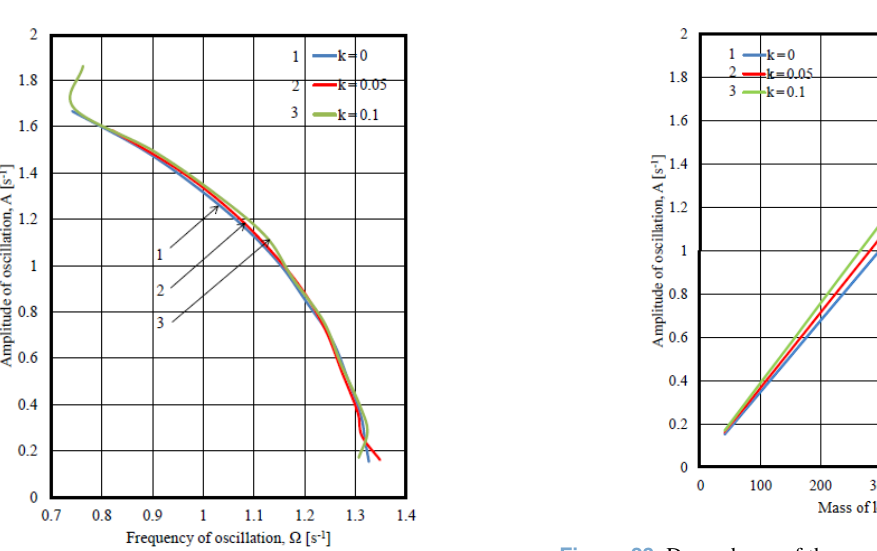
Figure 23. Dependence of the amplitude of oscillations of angular velocity on the load mass in different values of coefficient of rota- tional friction and coefficient of sliding friction f =